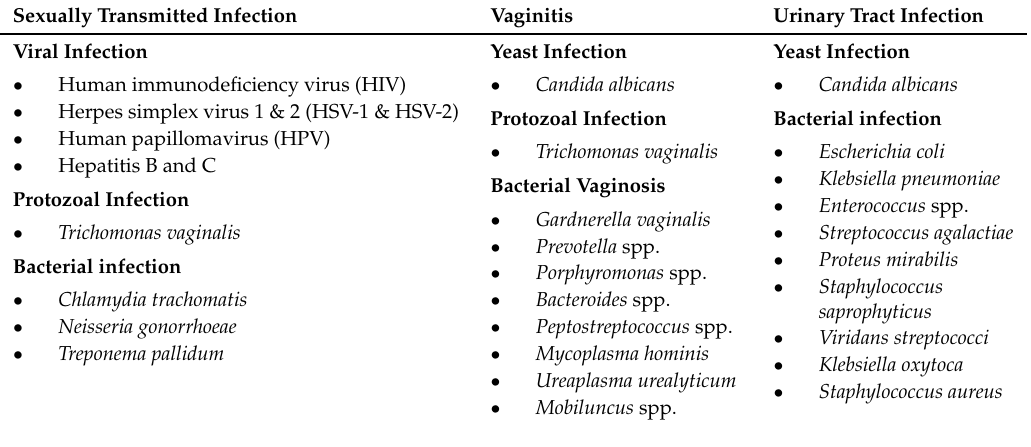
Table 1. Common microorganisms that cause sexually transmitted infection and genitourinary tract